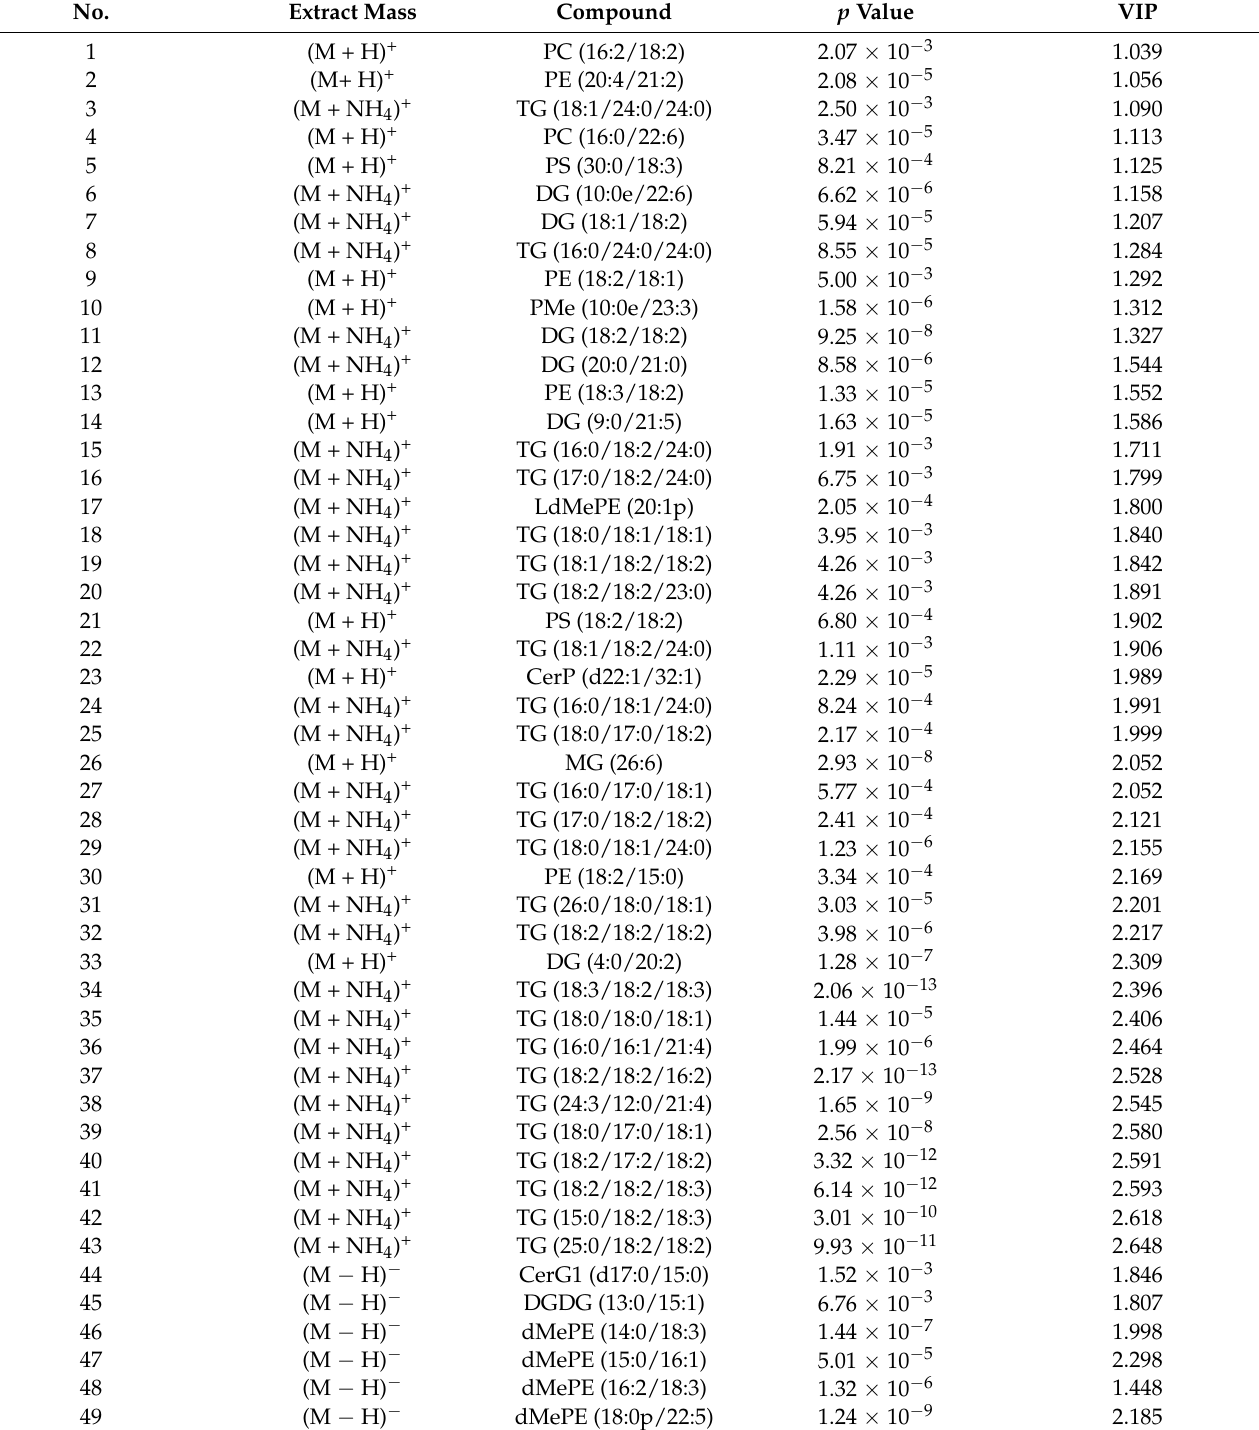
Table 1. Significantly altered lipid metabolites among the control and the CV-treated groups by the ANOVA test analysis with Fisher’s post hot analysis and OPLS-DA